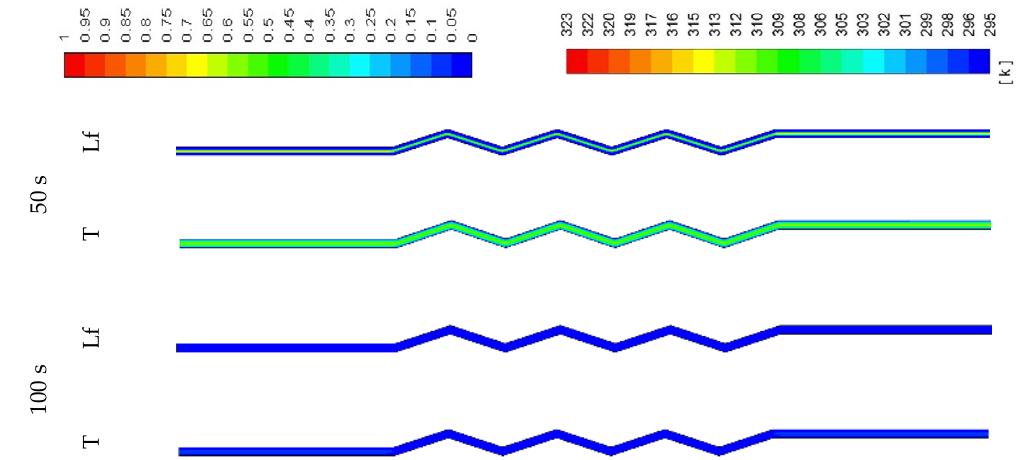
Figure 19. Contours of the liquid-fraction and temperature in a solidification process for the half-width (0.5 W) horizontal corrugated channel.